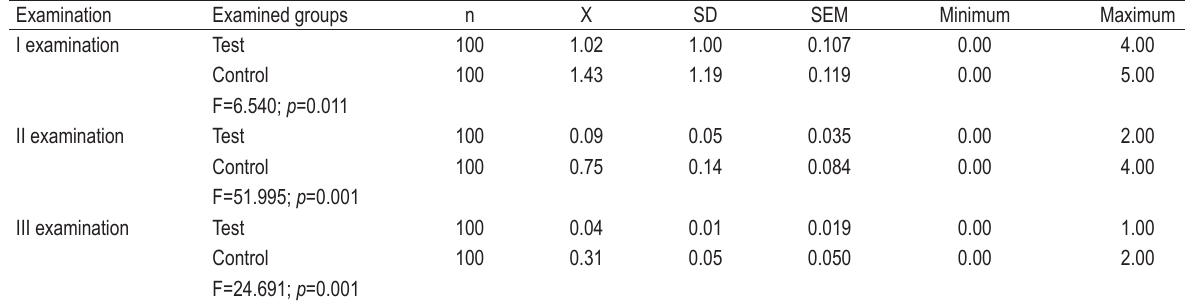
TABLE 4. Analysis of the ability to walk in both examined groups